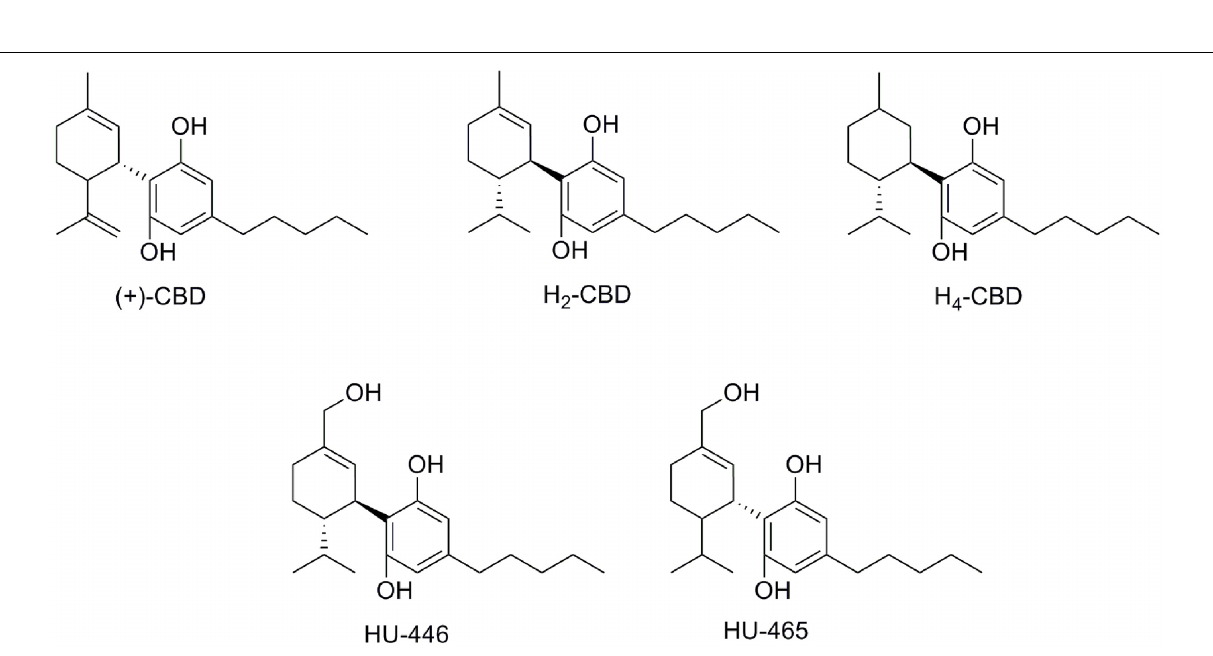
FIGURE 5 | Cannabidiol (CBD)-related Machaerium multiflorum , Rhododendron ferrugineum L. and, Lindera umbellata Thunb. compounds.